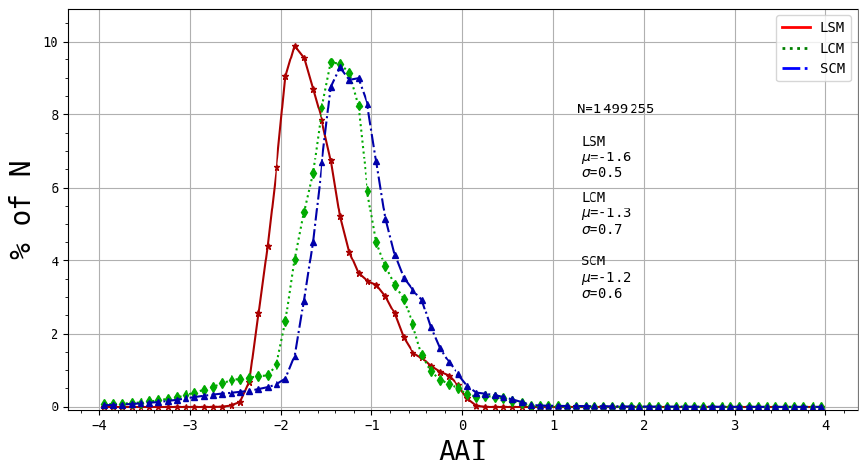
Figure 15. Histograms of the AAI value occurrence in the LSM (red), LCM (green), and SCM (blue). The vertical axis displays the percentage of total measurements. The mean µ and standard deviation σ of each histogram are given in the legend. N is the total number of